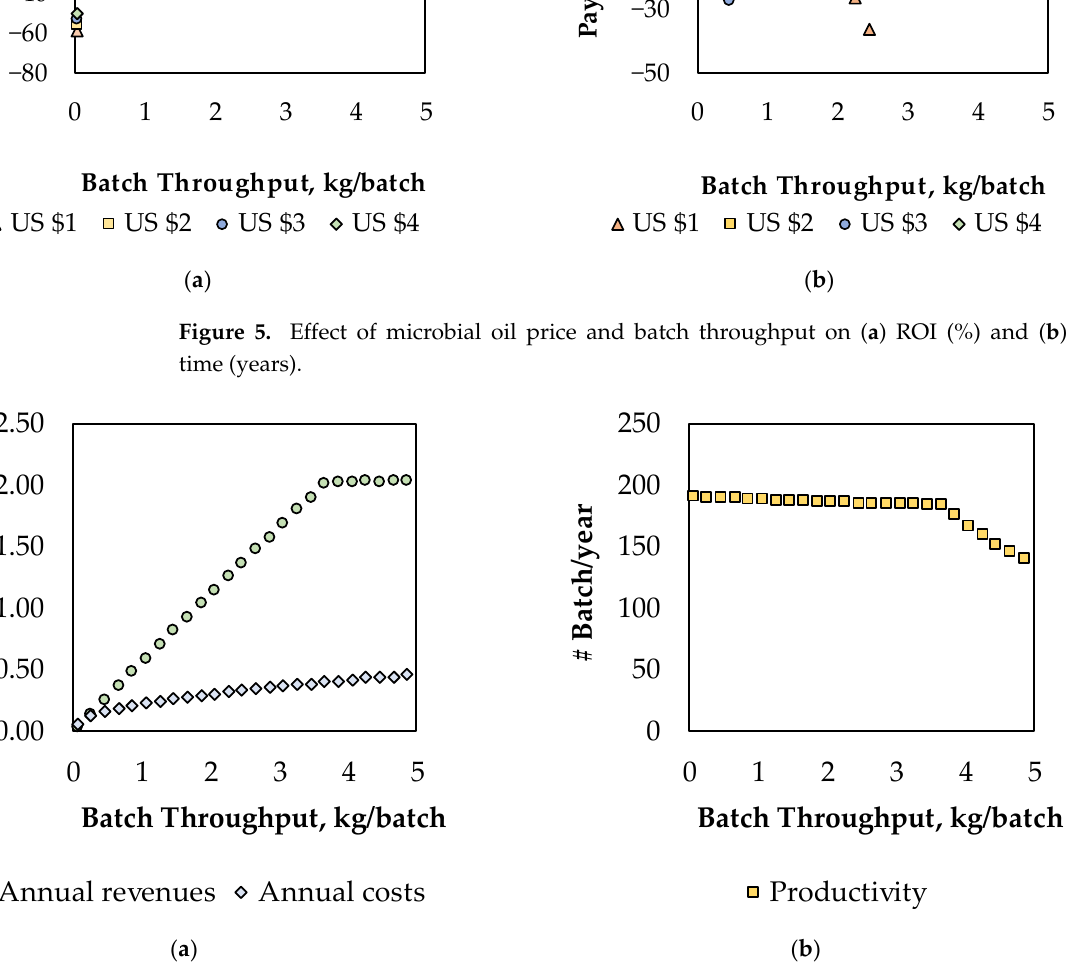
Figure 6. ( a ) Break-even point of annual revenues and costs. ( b ) Batches per year as a function of the process throughput.